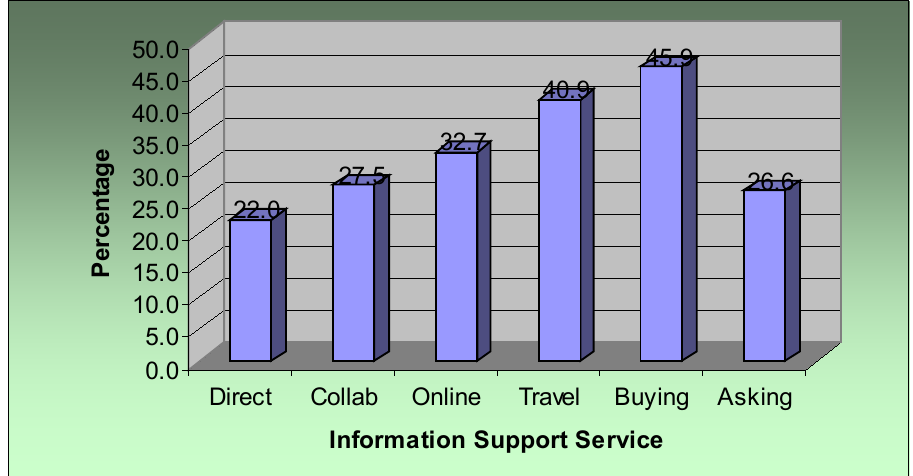
Figure 3. How students access information resources and